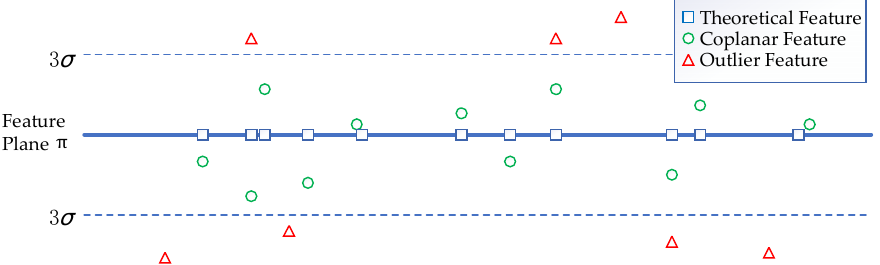
Figure 5. In the feature map, the existing feature points are used to fit the ceiling plane π . The points within the tolerance are regarded as coplanar features on the surface, and the points outside the tolerance are eliminated without fitting the final feature plane. The basis for fitting the plane is that theoretically, the features on the ceiling must be on the plane.